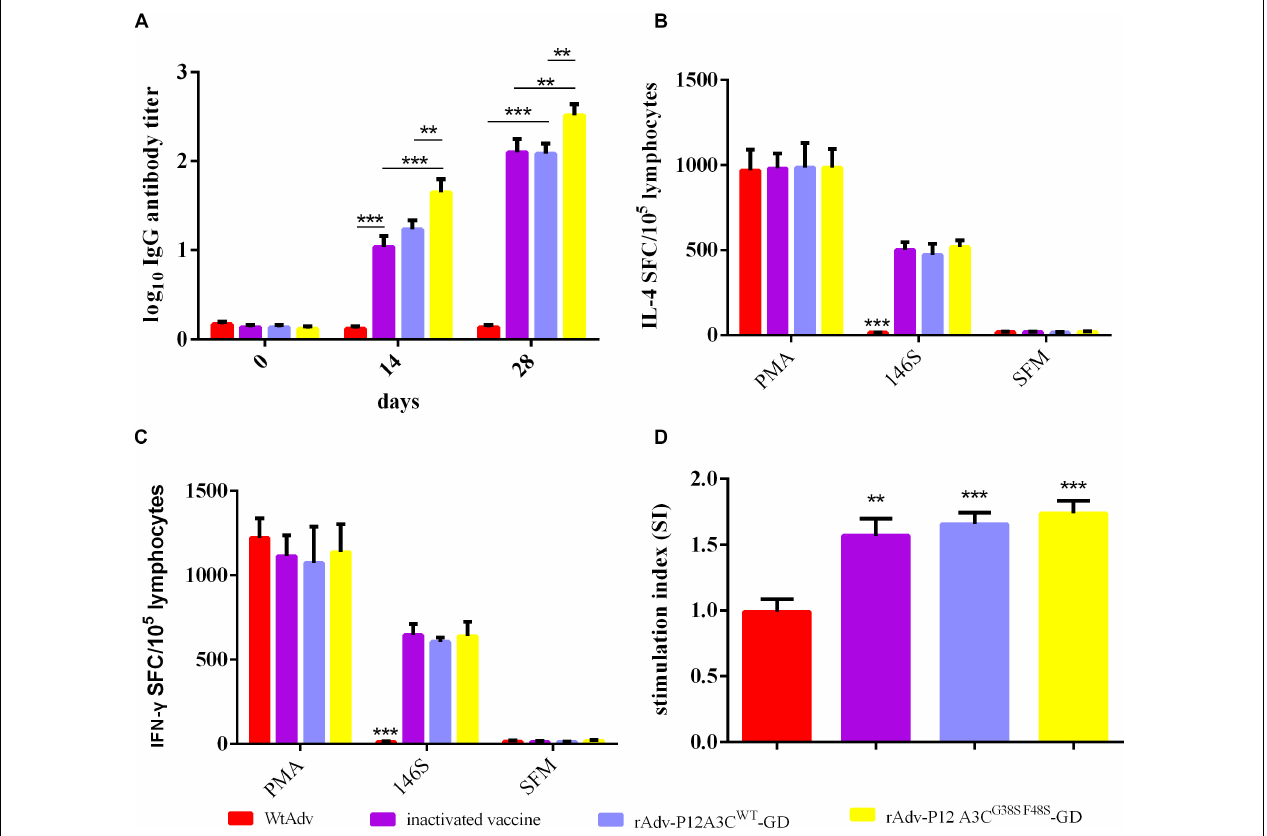
FIGURE 4 | High anti-FMDV IgG antibody titers and cellular immune responses were induced in BALB/c mice. (A) Antibodies raised against serotype A FMDV were measured with LPB-ELISA. (B) Levels of mouse cytokine IL-4. The spot-forming cells (SFC) were counted after the plates were air-dried. (C) Levels of mouse cytokine IFN- γ . (D) Mean stimulation index (SI) of mice immunized with WtAdv, inactivated FMDV vaccine, rAdv-P12A3C WT -GD, or rAdv-P12A3C G38SF48S -GD at 28 dpi. Results are presented as means ± SD ( n = 3).